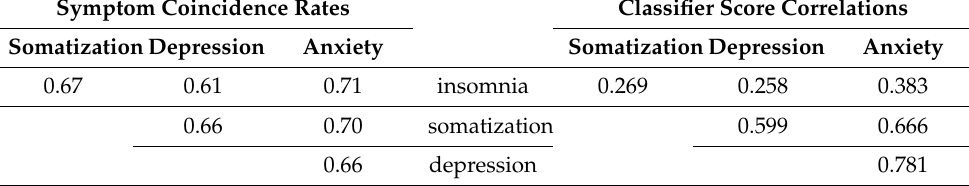
Table 4. Left panel: symptom coincidence rate. The fraction of the TEAM-TBI cohort who screened positive for at least two symptoms is shown. For example, 61% of the TEAM-TBI cohort screened positive for both insomnia and depression. Right panel: correlations between classifier scores for the TEAM-TBI cohort. See the text for